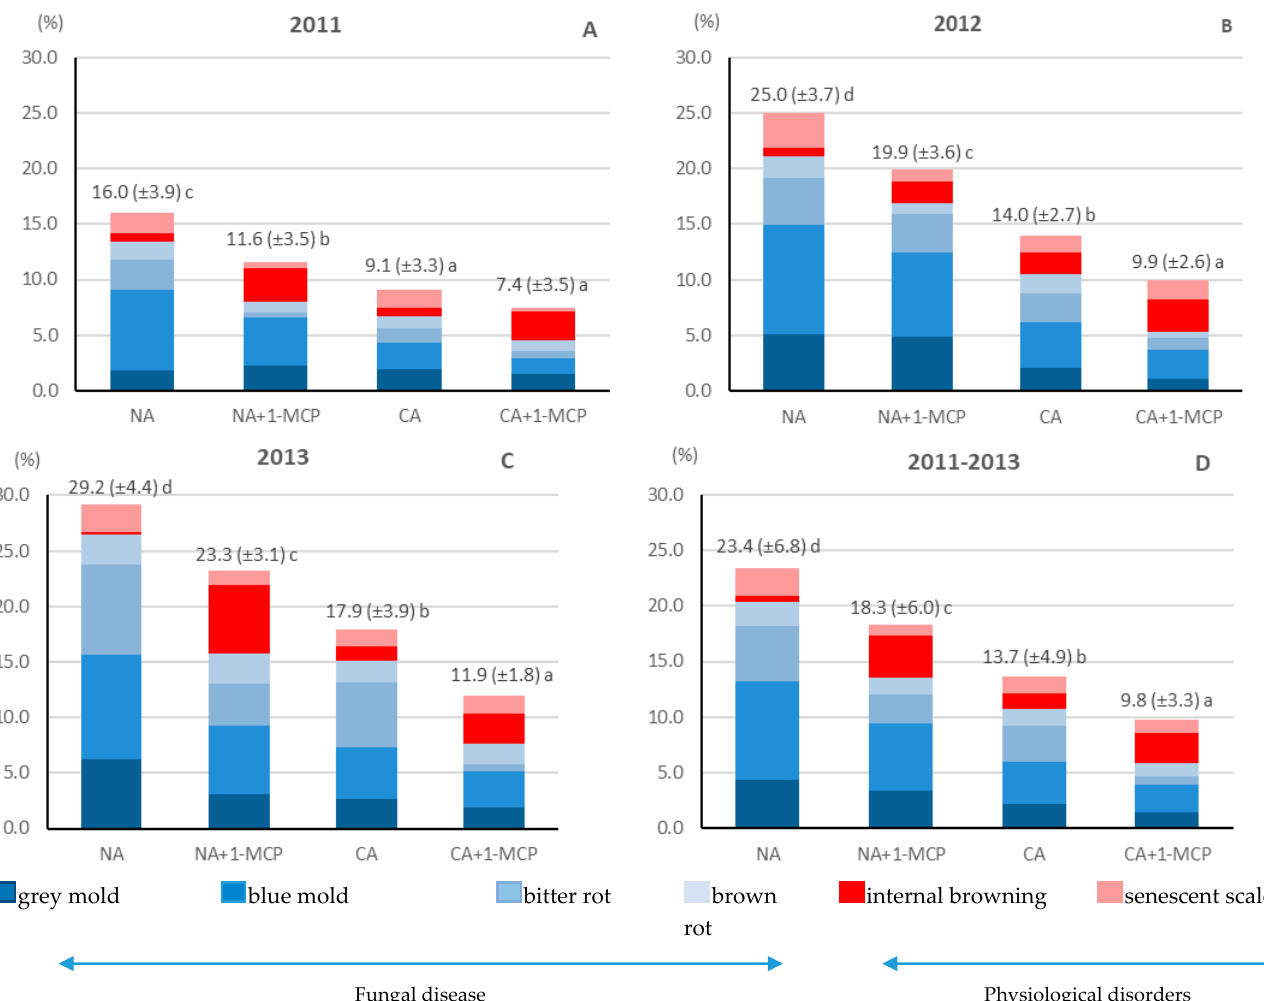
Figure 1. Total fruit losses caused by fungal diseases and physiological disorders. Numbers with different letters were significantly different at p = 0.05 according to Duncan’s test. The data are expressed as mean ± SD (n = 10). NA—normal atmosphere; NA + 1-MCP—normal atmosphere + 1-methylcyclopropene; CA—controlled atmosphere; CA + 1-MCP—controlled atmosphere + 1-methylcyclopropene.